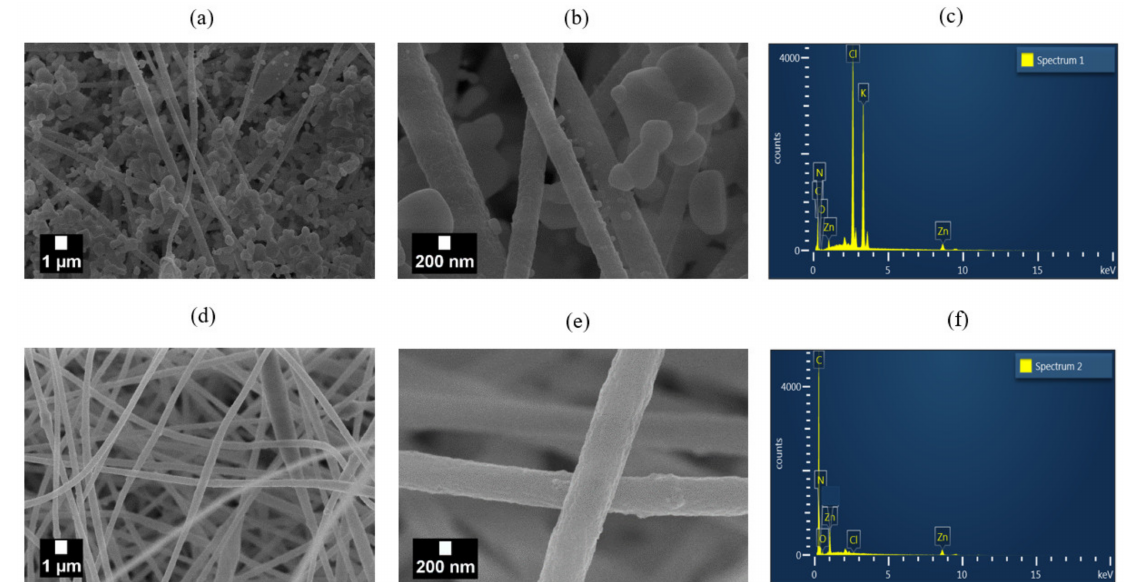
Figure 9. SEM images of PZ12(0.5S)-based filter: after filtration test ( a , b ), after washing with DW ( d , e ); EDX analyses are presented in ( c , f ), respectively.